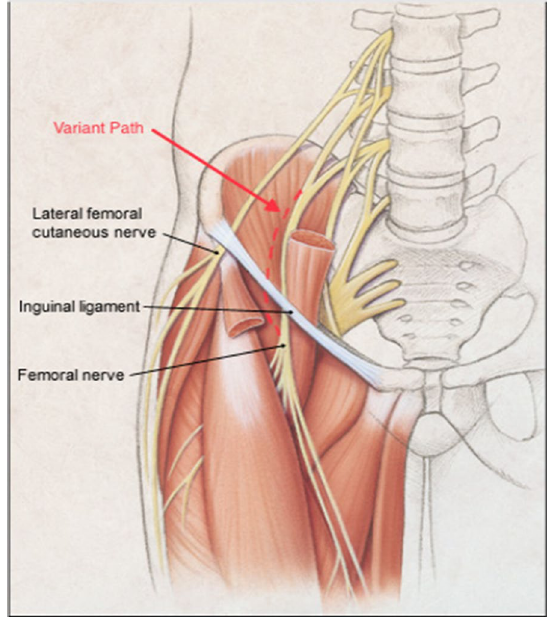
Fig. 1 Diagram of typical anatomical relationship of femoral nerve and iliacus muscle. Variant path is mapped in